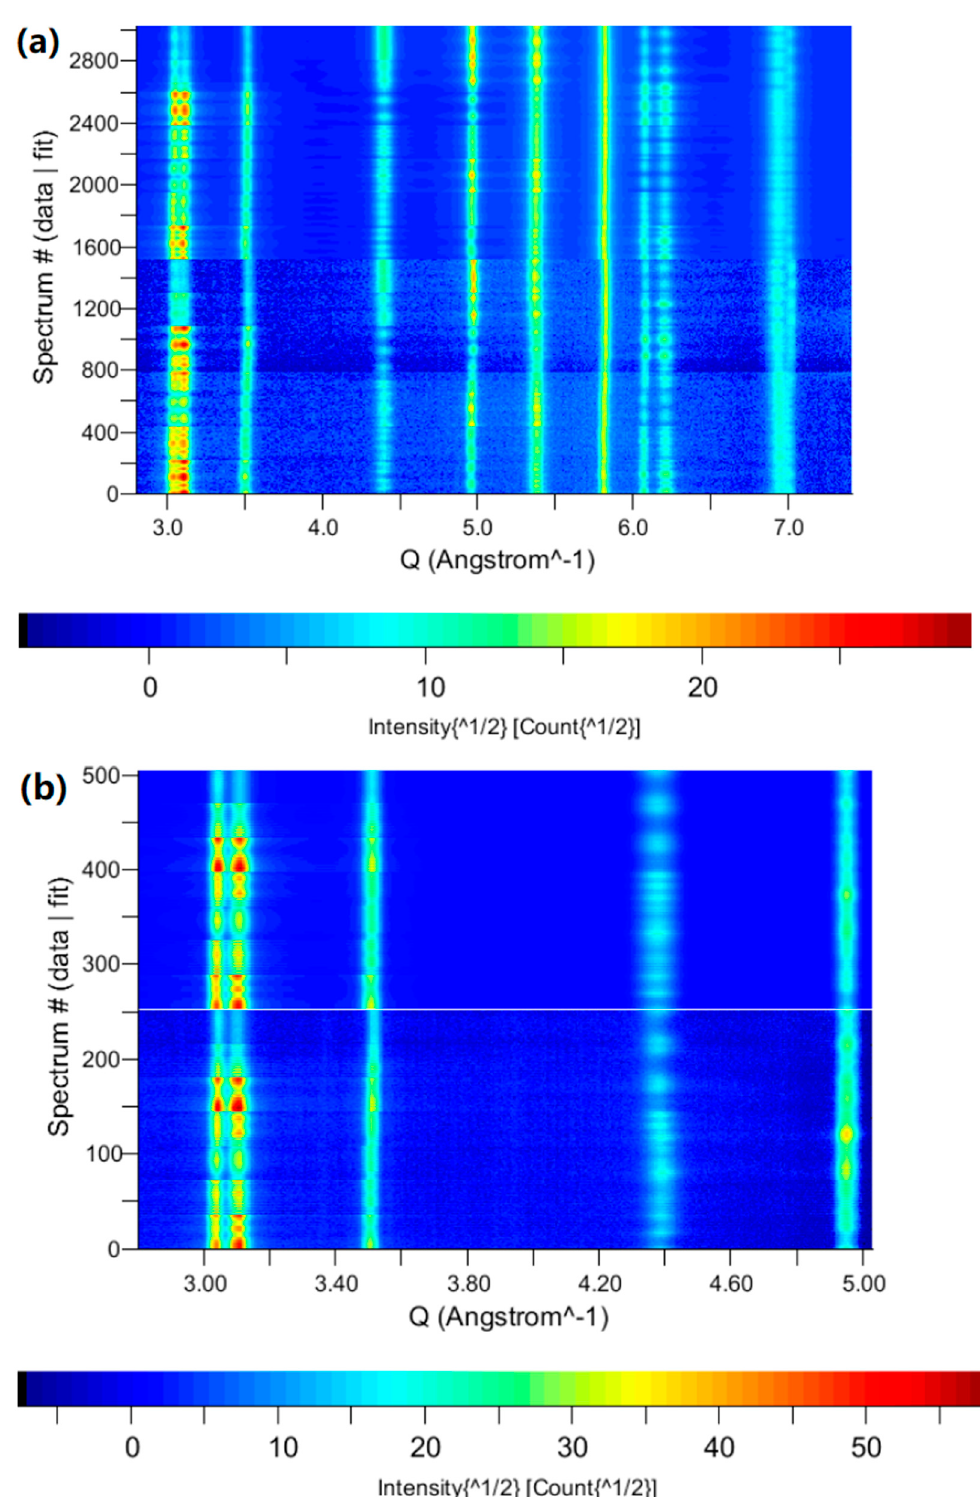
Figure 7. Line-plots for the measured diffractograms ( lower half ) and their Rietveld fitted profiles ( upper half ) of the multilayered steel sheets obtained by combined MAUD–Rietveld texture analysis. ( a ) at short wavelength λ 1 = 1.54 Å, large wavenumber k 1 = 4.08 Å − 1 ; ( b ) at long wavelength λ 2 = 2.41 Å, small wavenumber k 2 = 2.61 Å − 1